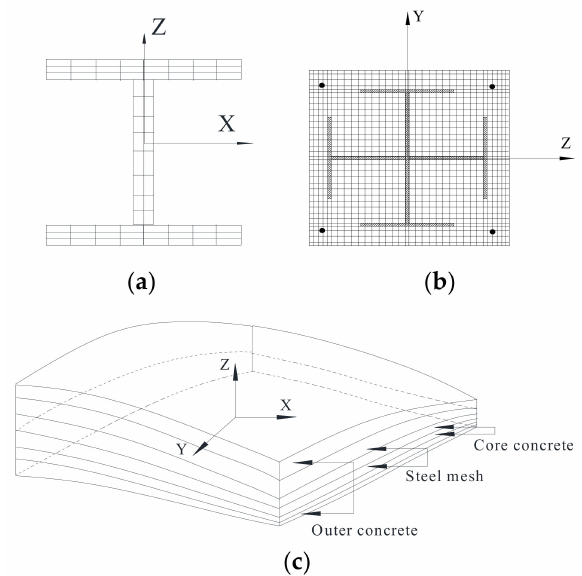
Figure 8. Fiber sections: ( a ) beam, ( b ) column and ( c ) wall and